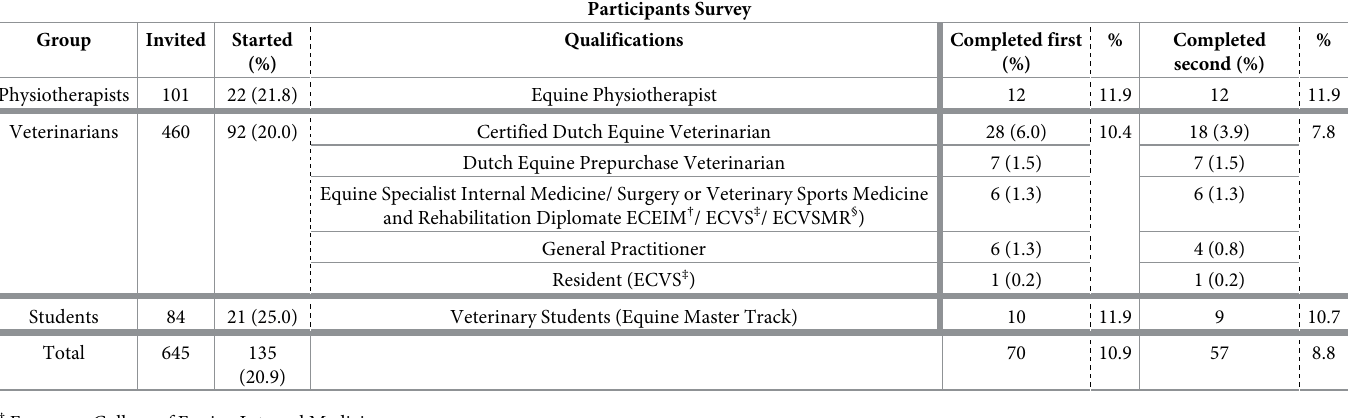
Table 1. Descriptive statistics of invited participants and those that eventually completed the first and second part of the survey. Participants